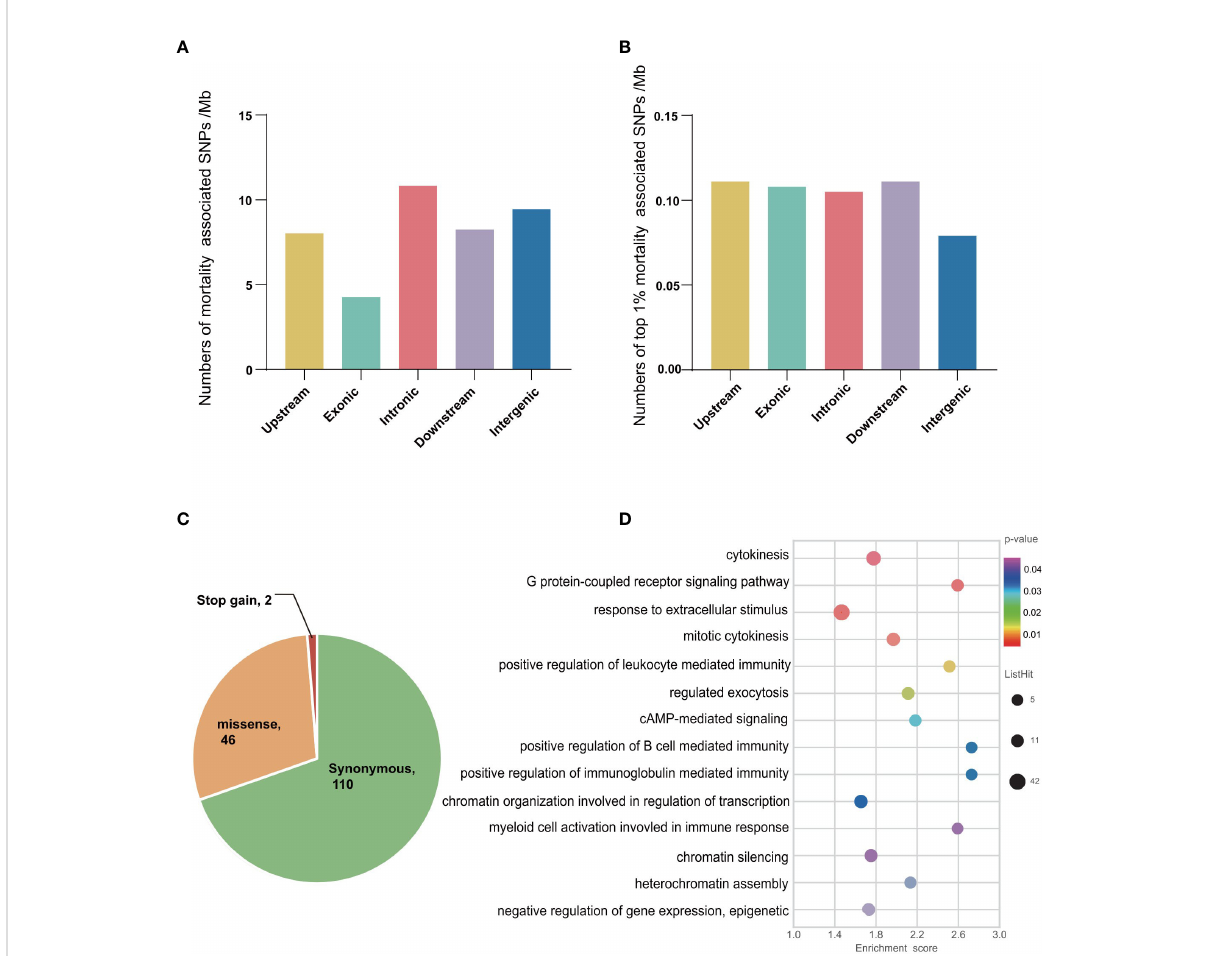
FIGURE 2 Description of mortality associated SNPs and genes in oyster larvae. (A) The number (per Mb) of mortality associated SNPs with base frequency not less than 0.5 between the susceptible and resistant larvae. (B) Statistics of the number (per Mb) of different classes of top 1% selective SNPs. (C) Characterization of mortality associated SNPs in exonic region. synonymous: causing no amino acid changes; non-synonymous: causing amino acid changes; stop gain: gain of stop codons. (D) Gene Ontology (GO) enrichment analyses of disease resistance associated genes in larvae. The 3,111 candidates were identi fi ed based on base frequency changes (no less than 0.5) and top 5% highest values of F ST analyses in the oyster larvae population.